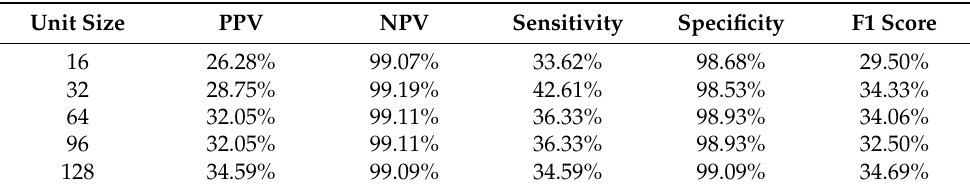
Table 6. Performance evaluation of the GRU model according to the GRU layer unit size. The highest PPV was 128 and highest NPV was 32. The highest sensitivity was 32 and highest specificity was 128. The highest F1 score was